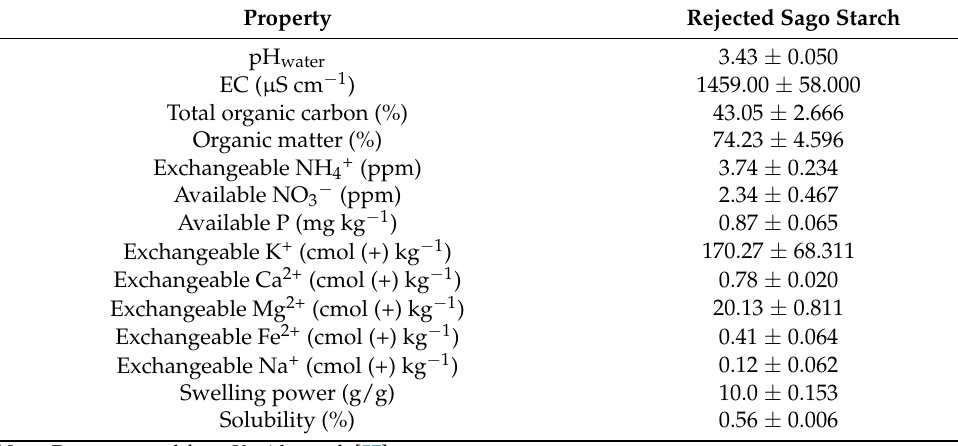
Table 2. Selected physical and chemical properties of rejected sago